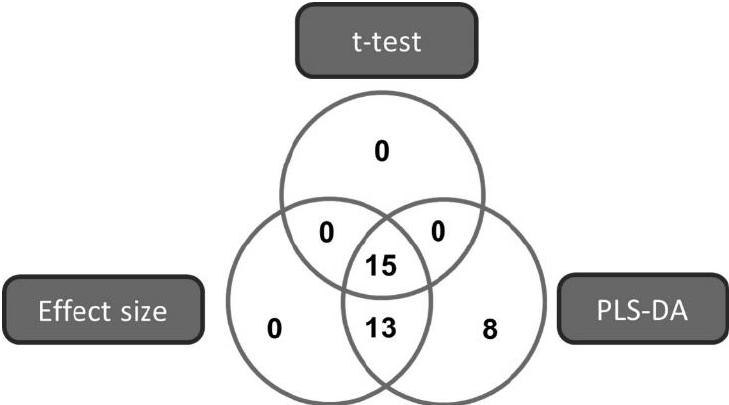
Figure 2. Venn diagram illustrating the multi-statistical approach for selecting the metabolites that best describe the variation detected in the metabolome of Mtb cultured with and without DQ derivative RMB041.